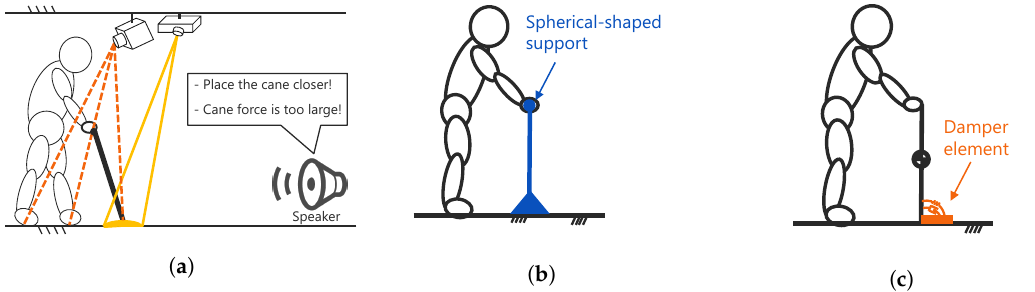
Figure 1. Application examples of support objects. ( a ) walking instruction system; ( b ) new-shaped support object; and, ( c ) cane with damper